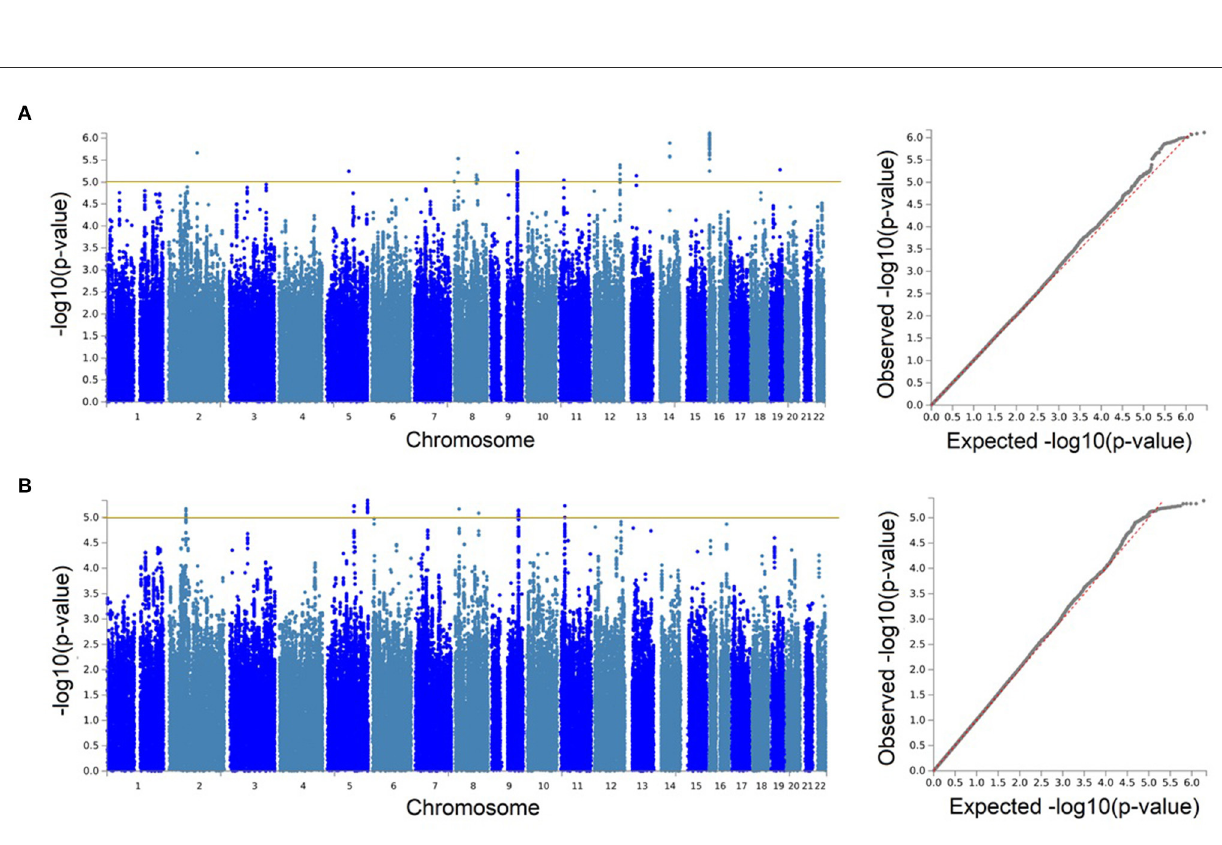
clearance-FDR = 0.03 in lilac module). Additionally,